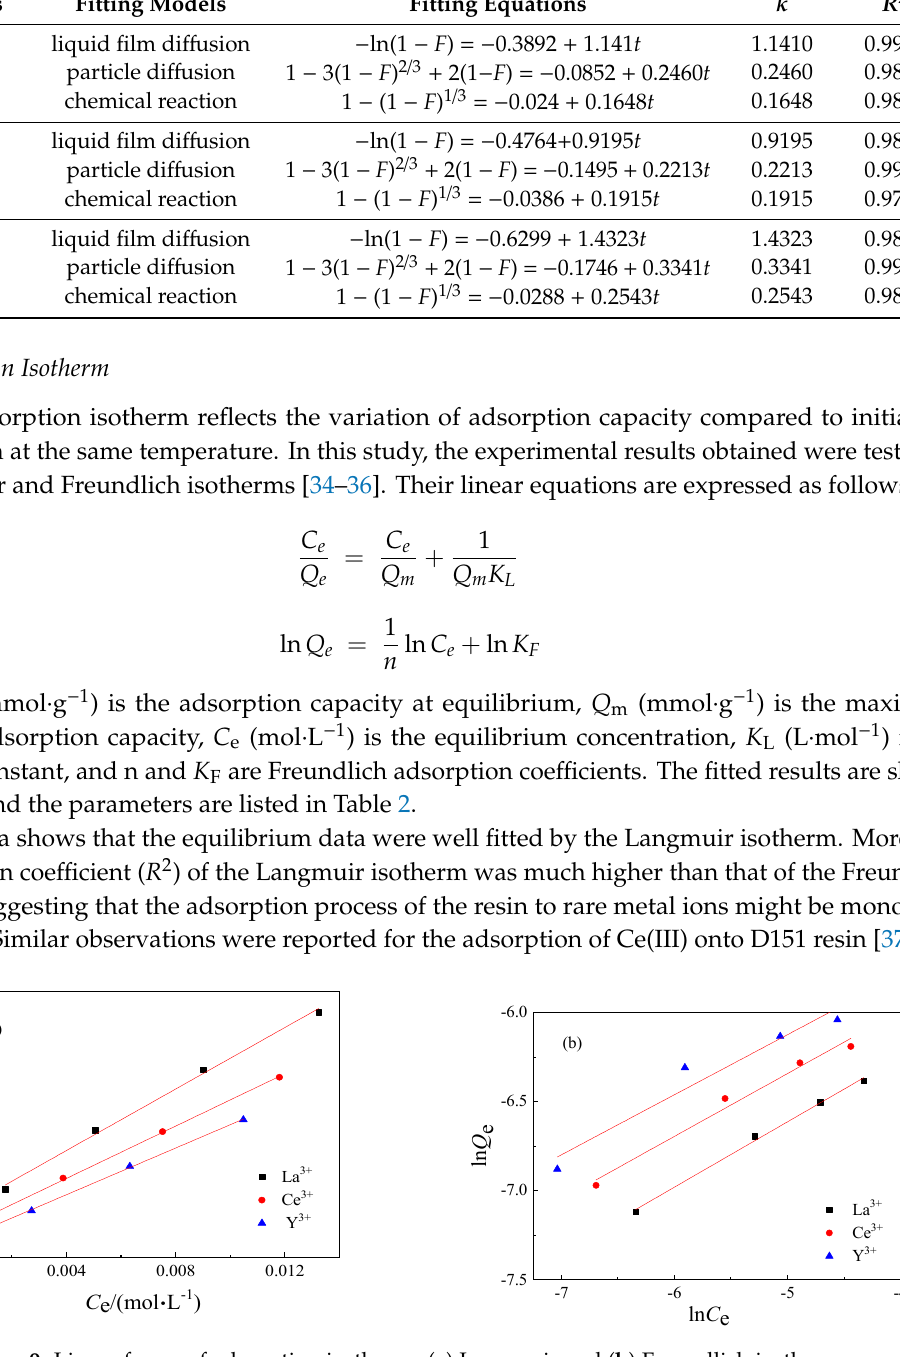
Figure 9. Linear forms of adsorption isotherm: ( a ) Langmuir and ( b ) Freundlich isotherms. Table 2. Langmuir and Freundlich adsorption isotherm parameters.